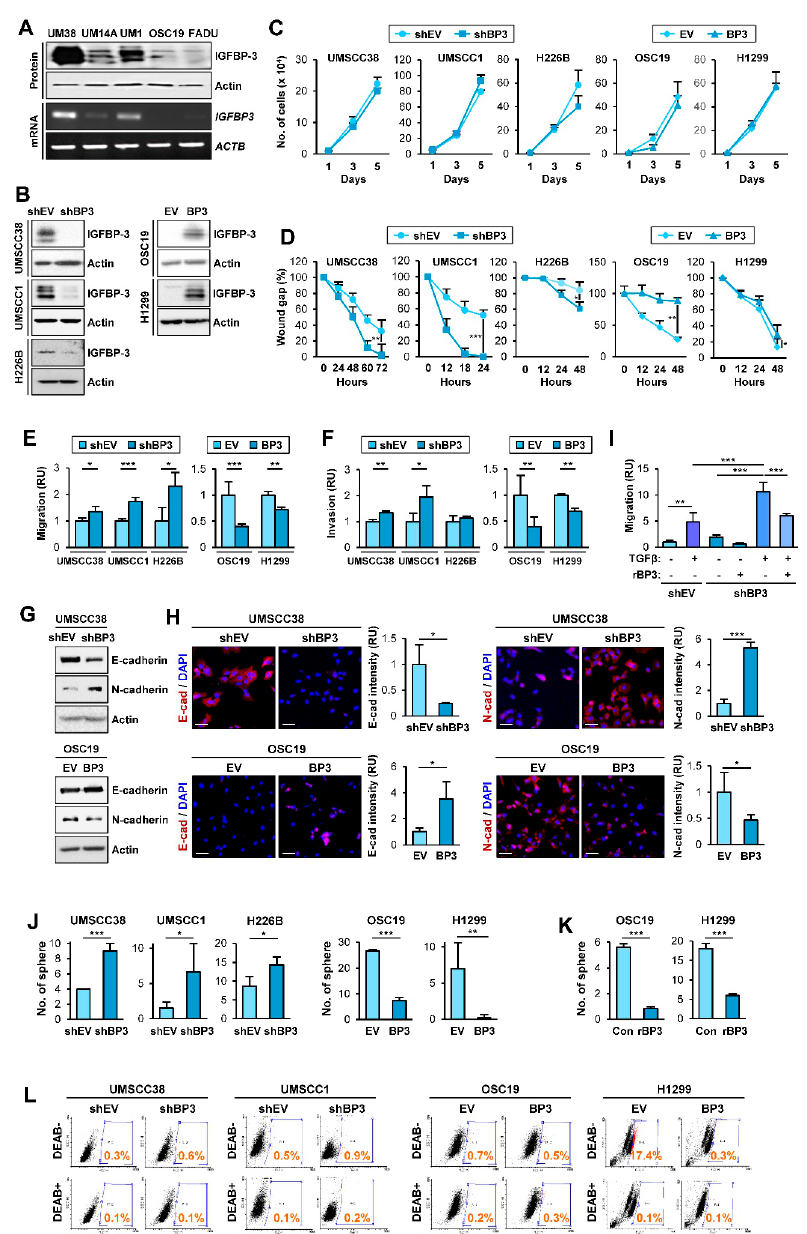
Figure 1. IGFBP-3 inhibits the acquisition of EMT and CSC-like phenotypes in HNSCC and NSCLC cells. ( A , B ) Western blot (WB) ( A , B ) and RT-PCR ( A ) analyses of IGFBP-3 expression in the indicated HNSCC cell lines ( A ) and HNSCC and NSCLC cell lines wherein IGFBP-3 expression was either silenced of enforced by stable transfection with shRNA or expression vector ( B ). ( C ) Effect of IGFBP-3 on cell proliferation was accessed by cell counting assay. ( D – F ) Effects of IGFBP-3 expression on the migration and invasion of the indicated cancer cells evaluated by a scratch assay ( D ) and by the Transwell migration ( E ) and invasion ( F ) assays. ( G , H ) WB ( G ) and IF ( H ) analyses for the protein expression of E-cadherin and N-cadherin in the indicated cancer cells with manipulation of IGFBP-3 expression. Quantification of the fluorescence intensity was analyzed by ImageJ software ( H ). Scale bars: 50 µ m ( H ). ( I ) UMSCC38-shEV and UMSCC38-shBP3 cells unstimulated or stimulated with TGF- β (10 ng/mL) in the absence or presence of recombinant IGFBP-3 (10 µ g/mL) for 48 h were subjected to the Transwell migration assay ( J – L ) Regulation of sphere formation ( J , K ) and ALDH activity ( L ) by manipulation of IGFBP-3 expression ( J , L ) or treatment with recombinant IGFBP-3 protein ( K ). The bar represents mean ± SD. * p < 0.05, ** p < 0.01, and *** p < 0.001, as determined by the two-tailed Student’s t -test compared with the corresponding control ( C – F , H , J , K ) and one-way ANOVA followed by Dunnett’s post-hoc test ( I ). UM38: UMSCC38; UM14A: UMSCC14A; UM1: UMSCC1; OSC19: OSC19-Luc. EV: empty vector; BP3: